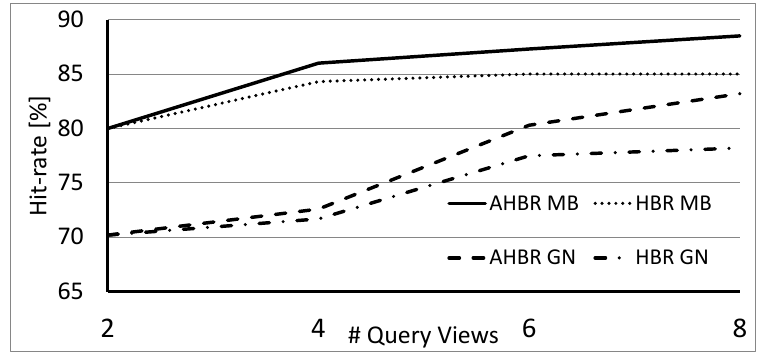
Figure 7. Average hit-rate obtained over the SUP-16 dataset with HBR and with AHBR ( ω = 0.5) in cases of different distortions of queries.